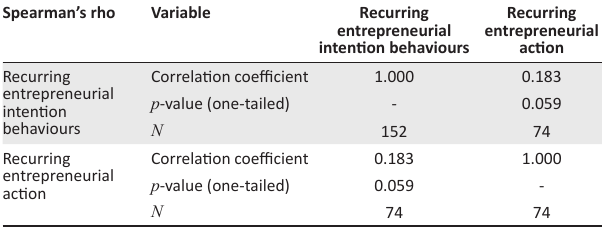
TABLE 2: Results of Spearman’s rank-order correlation.